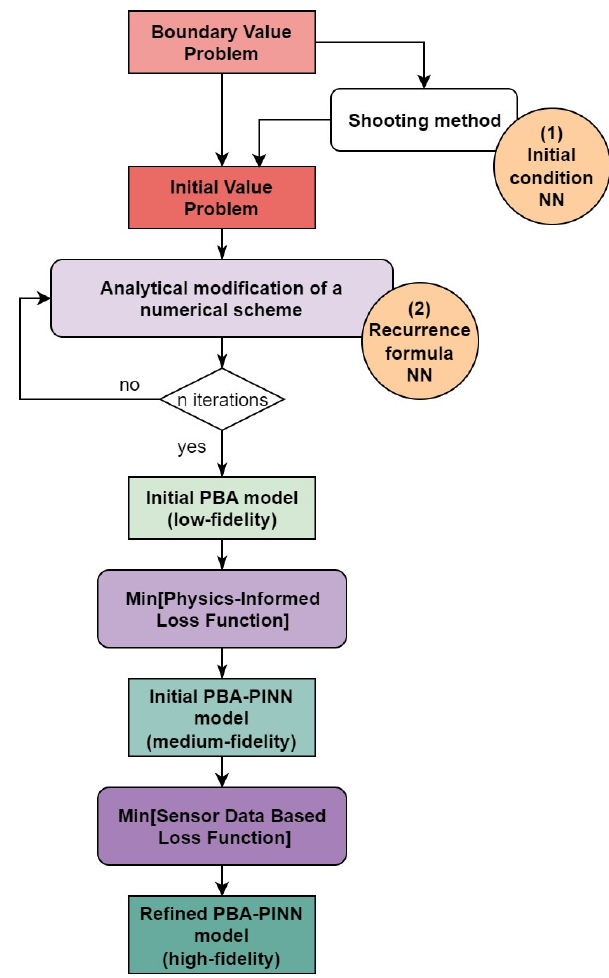
Figure 1. General scheme of constructing and training multi-fidelity physics-informed neural net- works with physics-based architecture